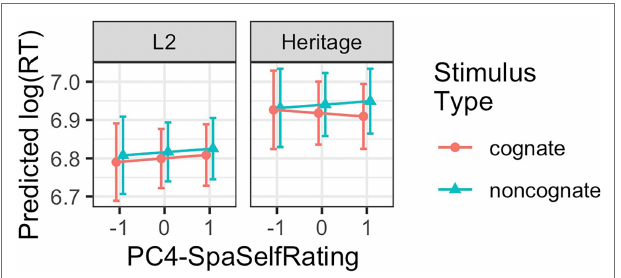
FIGURE 4 | Predicted response times (estimated marginal means with prediction intervals) showing the interaction of stimulus type, participant group, and PC4-SpanishSelfRating (centered and scaled), using the fitted model from Table 8 .